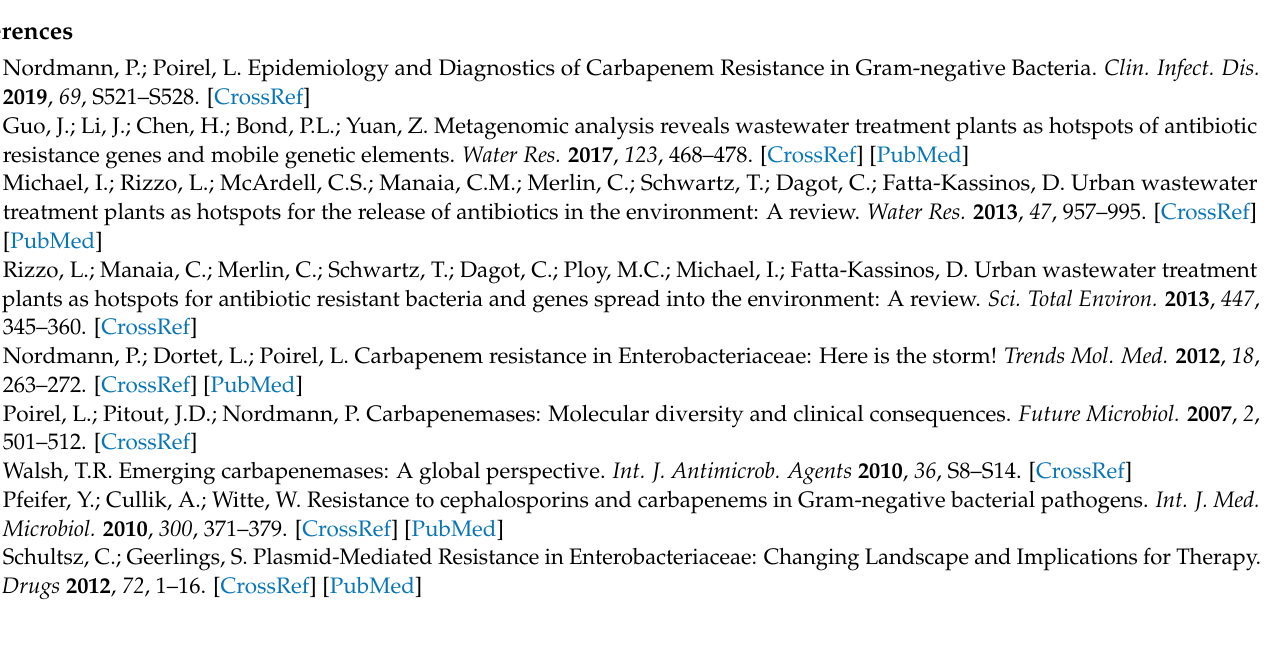
Table S8: Information about the sequence and amplicon size of the primers and probes used in each TaqMan qPCR reaction; Table S9: Information about the concentrations and volumes of